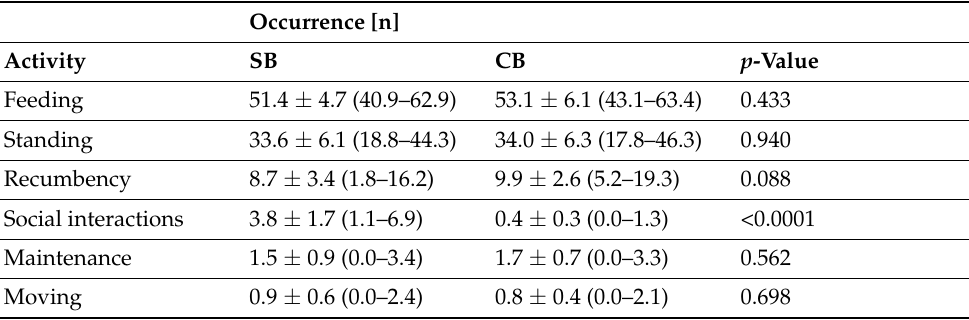
Table 5. Activity budget in the social box (SB) and the conventional box (CB) stabling presented in percentage of occurrences (mean ± SD (range)) for each activity recorded by scan sampling during the time spent in the box in absence of a human.